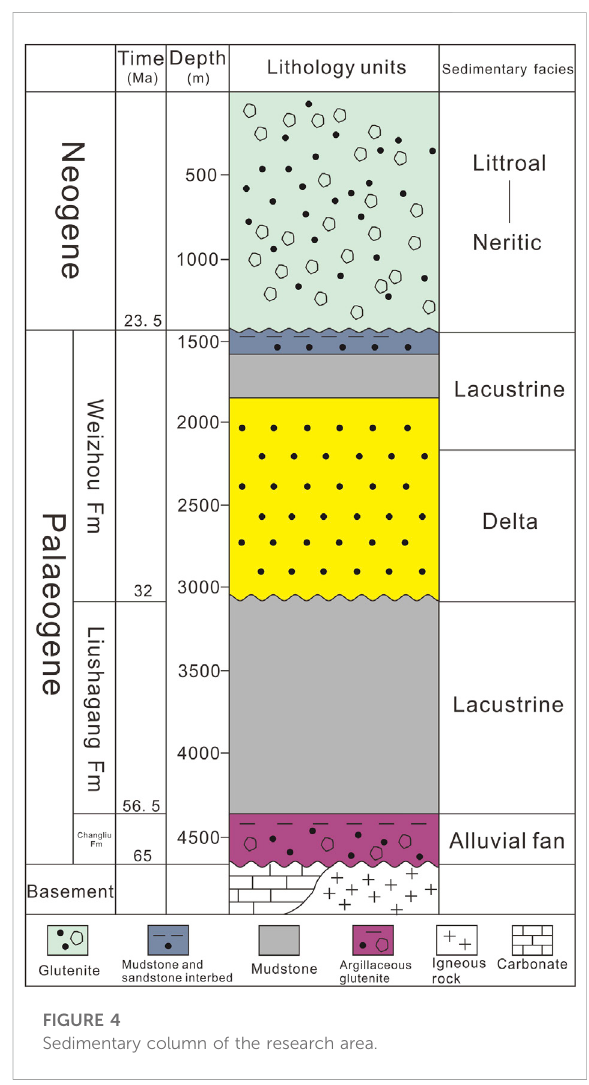
FIGURE 4 Sedimentary column of the research